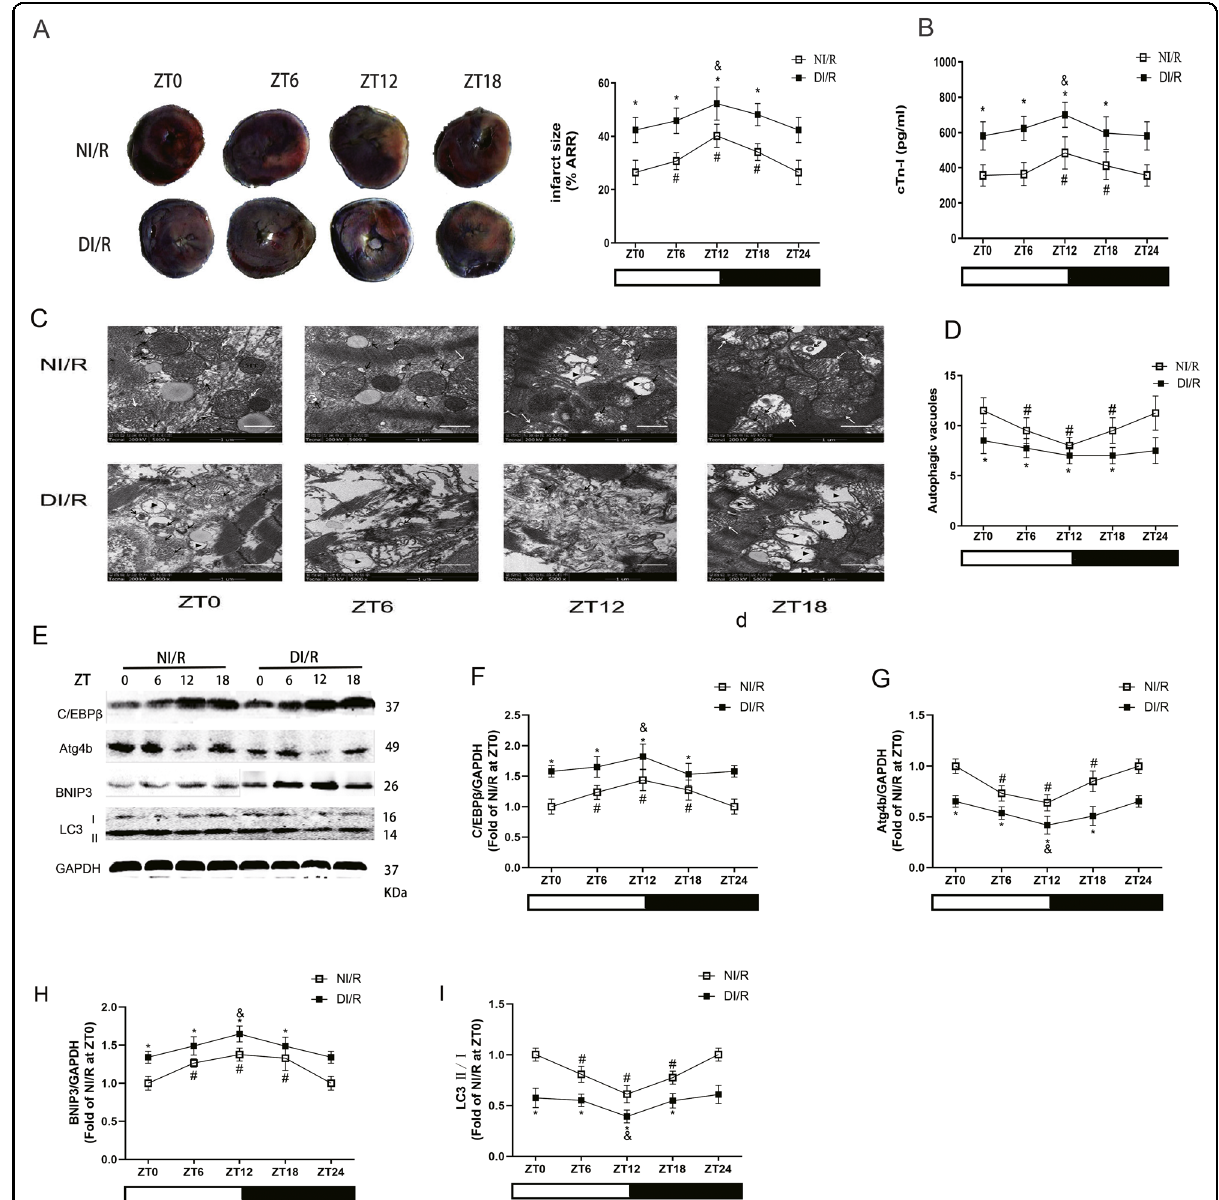
Fig. 2 The circadian dependence of MI/RI in diabetic rats was attenuated, which was associated with disordered rhythm of mitophagy. A Infarct size was detected by TTC. Scale bar: 2 mm. B The serum level of cTn-I was detected by ELISA in non-diabetes or diabetes with I/R insult. C and D The ultrastructural changes and autophagic vacuoles of rat hearts were detected by TEM (MT: normal mitochondrion, white arrows: swollen mitochondrion, ▶ : disorganized and vacuolated mitochondrion, black arrows: autophagosome/autophagic vacuole, Scale bar: 1 μ m. E – I The protein levels of C/EBP β ( F ), Atg4b ( G ), BNIP3 ( H ) and LC3 II/I ( I ) were detected by western blotting in the myocardial tissues of non-diabetes or diabetes with I/R insult. n = 6 per group. * P < 0.05 versus NI/R within ZT; # P < 0.05 versus ZT0 within NI/R; & P < 0.05 versus ZT0 within